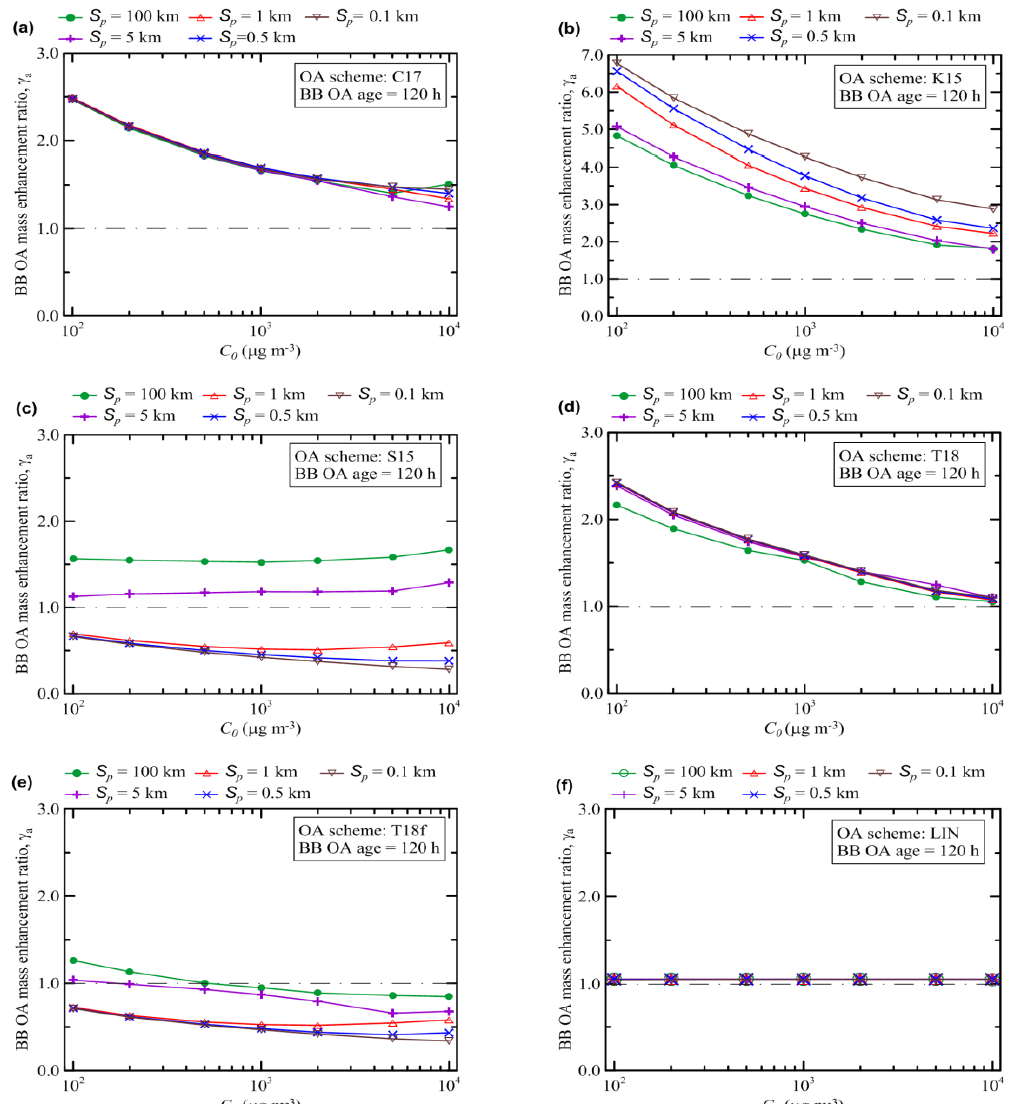
Figure 7. The same as in Fig. 6 but for the BB OA enhancement ratio after 120h of evolution and except that the ratio of C tot to C 0 (which is not supposed to characterize the state of BB OA after 5d aging) is not shown. Note that the y axis scale in the panel (b) is not the same as in other panels. A horizontal dashed–dotted line in each panel indicates the situation where no BB OA mass enhancement occurs ( γ a = 1).